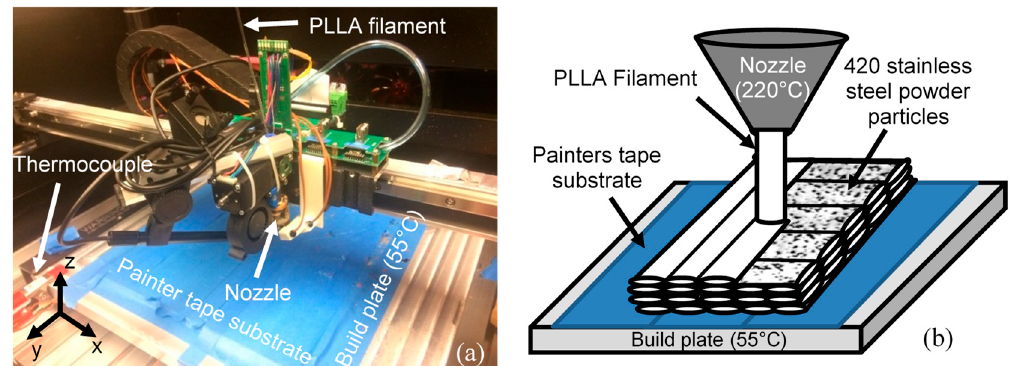
Figure 1. Equipment and schematic of 3D printing poly- L -lactic acid (PLLA) Steel composite, ( a ) fused